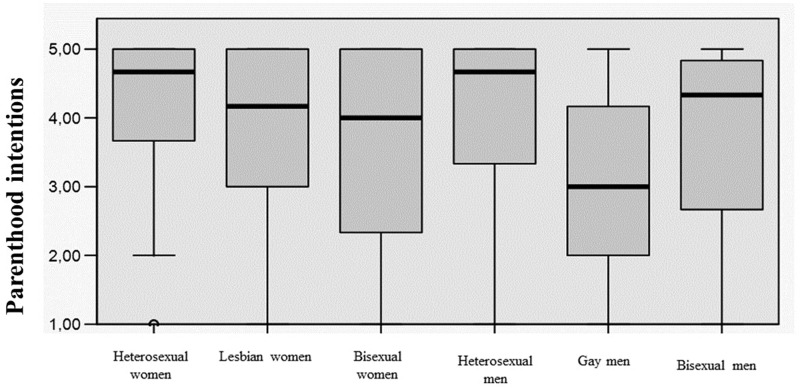
Box plot of the distribution of parenthood intentions among heterosexual women, lesbian women, bisexual women, heterosexual men, gay men, and bisexual men.